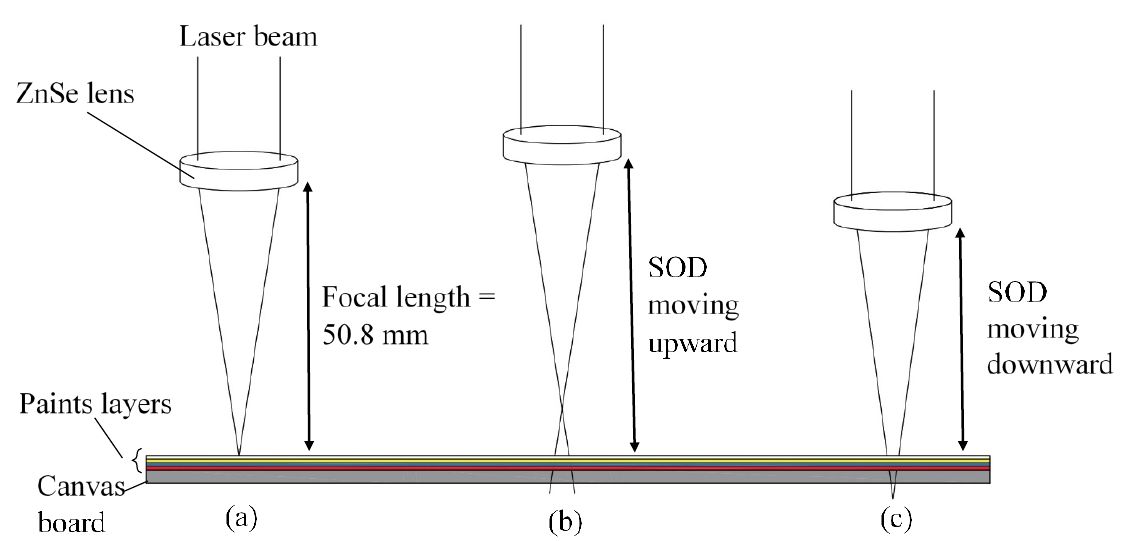
Figure 3. CO 2 laser machine.